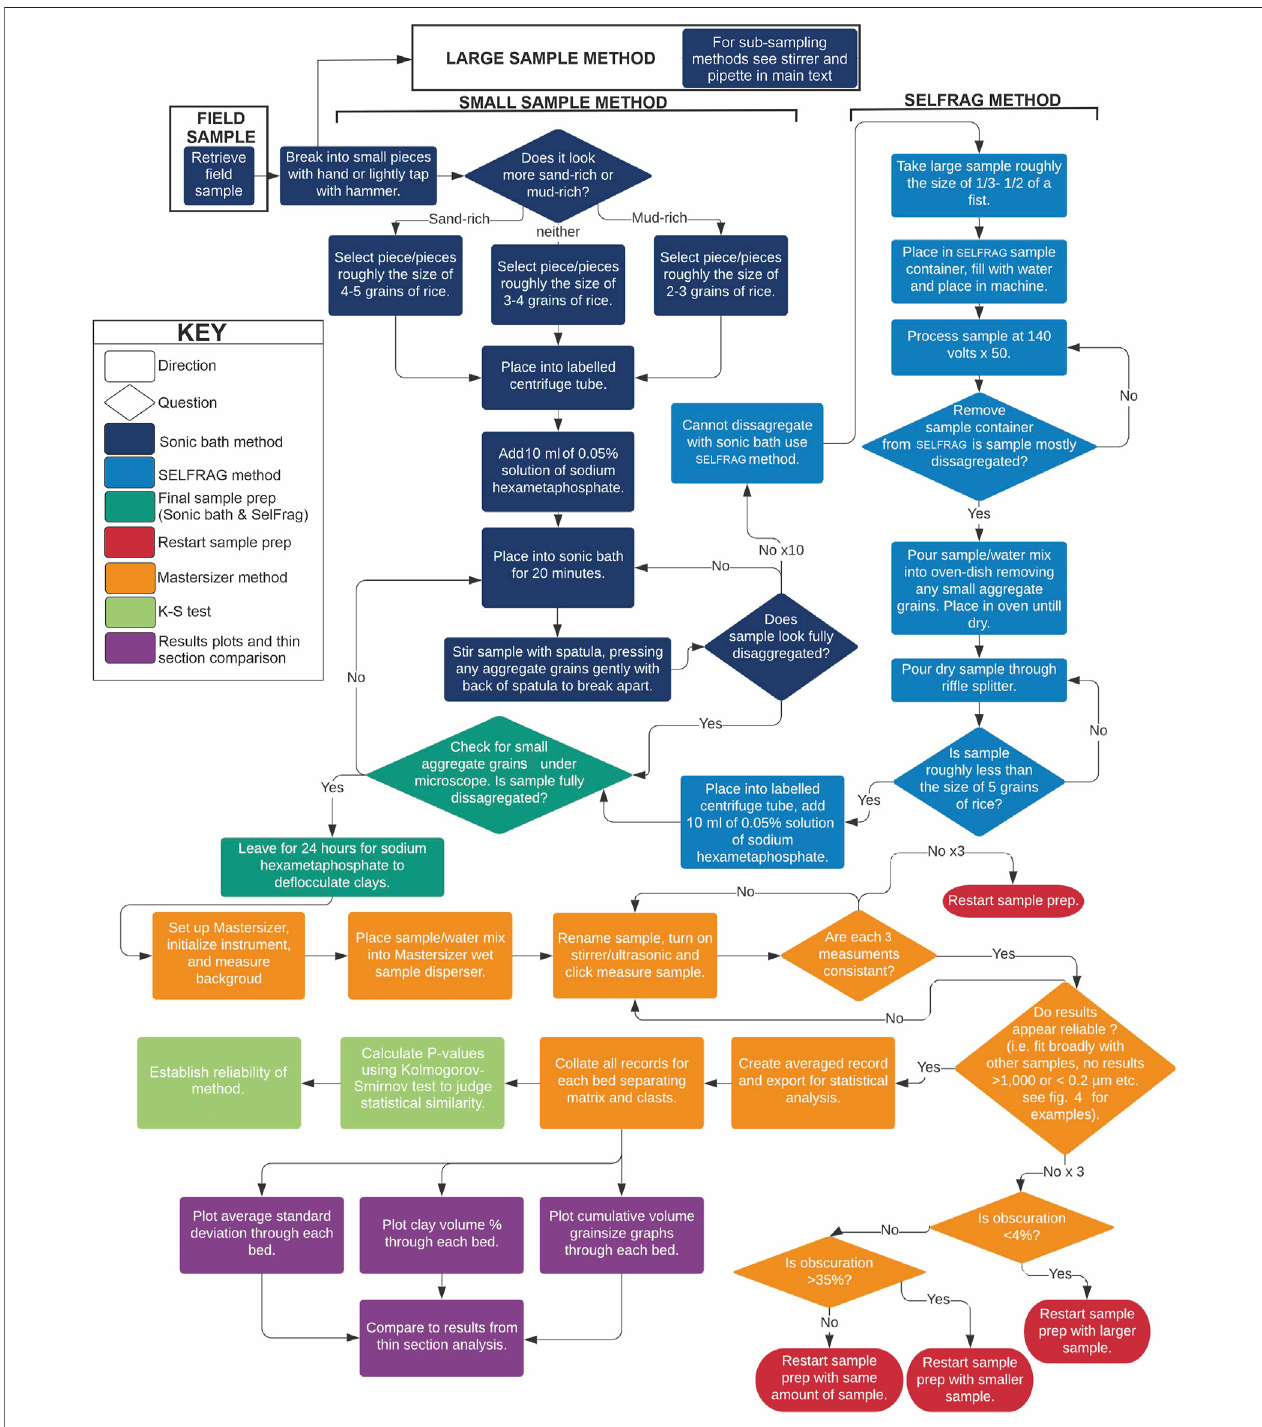
FIGURE 2 | Flow chart depicting entire work fl ow of study, including sample disaggregation methods, grain-size analysis and data processing. Each method is further explained in the text.